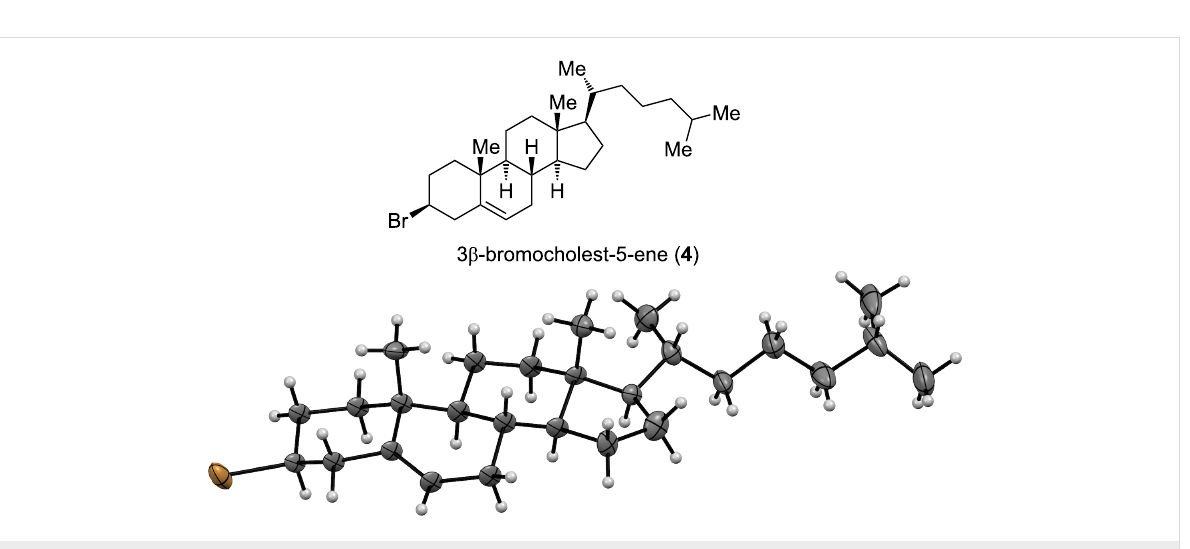
Figure 4: Top: the more polar product from the Appel reaction 3 β -bromocholest-5-ene ( 4 ); bottom: X-ray structure of 4 with thermal displacement pa- rameter at 50% probability